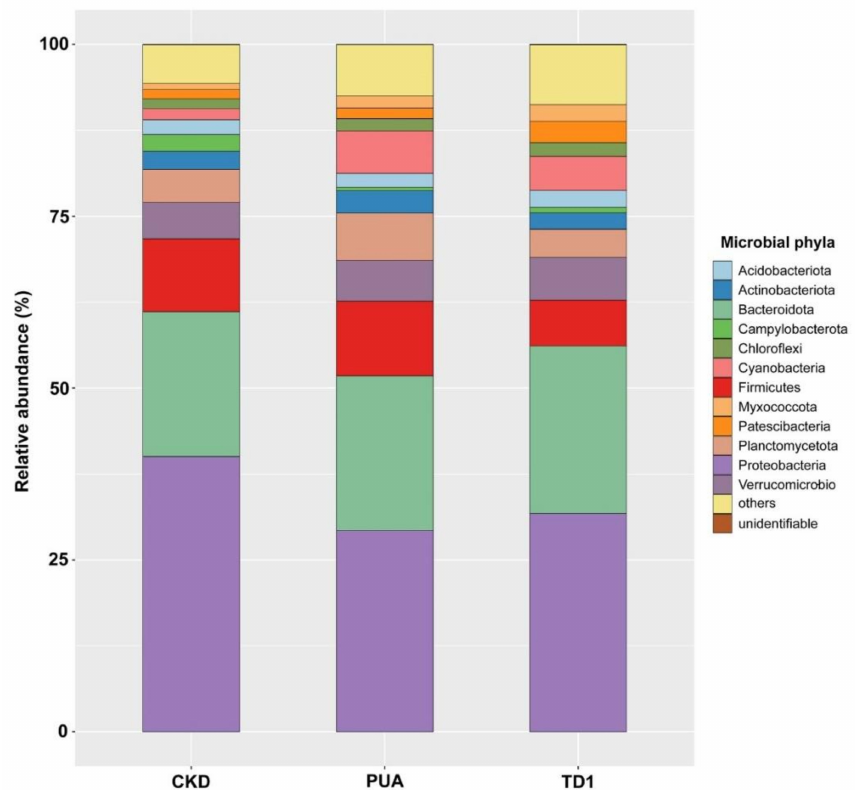
Figure 3. Results from 16S rDNA amplicon analysis of Cladophora sp. collected from Nan River, sites CKD, PUA, and TD1, showed that bacterial phyla and their relative abundance varied. The five most abundant phyla in site CKD were Proteobacteria (40.04%), Bacteroidetes (21.07%), Firmicutes (10.59%), Verrucomicrobia (5.30%), and Planctomycetes (4.80%). The five most abundant phyla in site PUA were Proteobacteria (29.29%), Bacteroidetes (22.50%), Firmicutes (10.86%), Planctomycetes (6.88%), and Cyanobacteria (6.20%). The five most abundant phyla in site TD1 were Proteobacteria (31.77%), Bacteroidetes (24.37%), Firmicutes (6.67%), Verrucomicrobia (6.22%), and Cyanobacteria